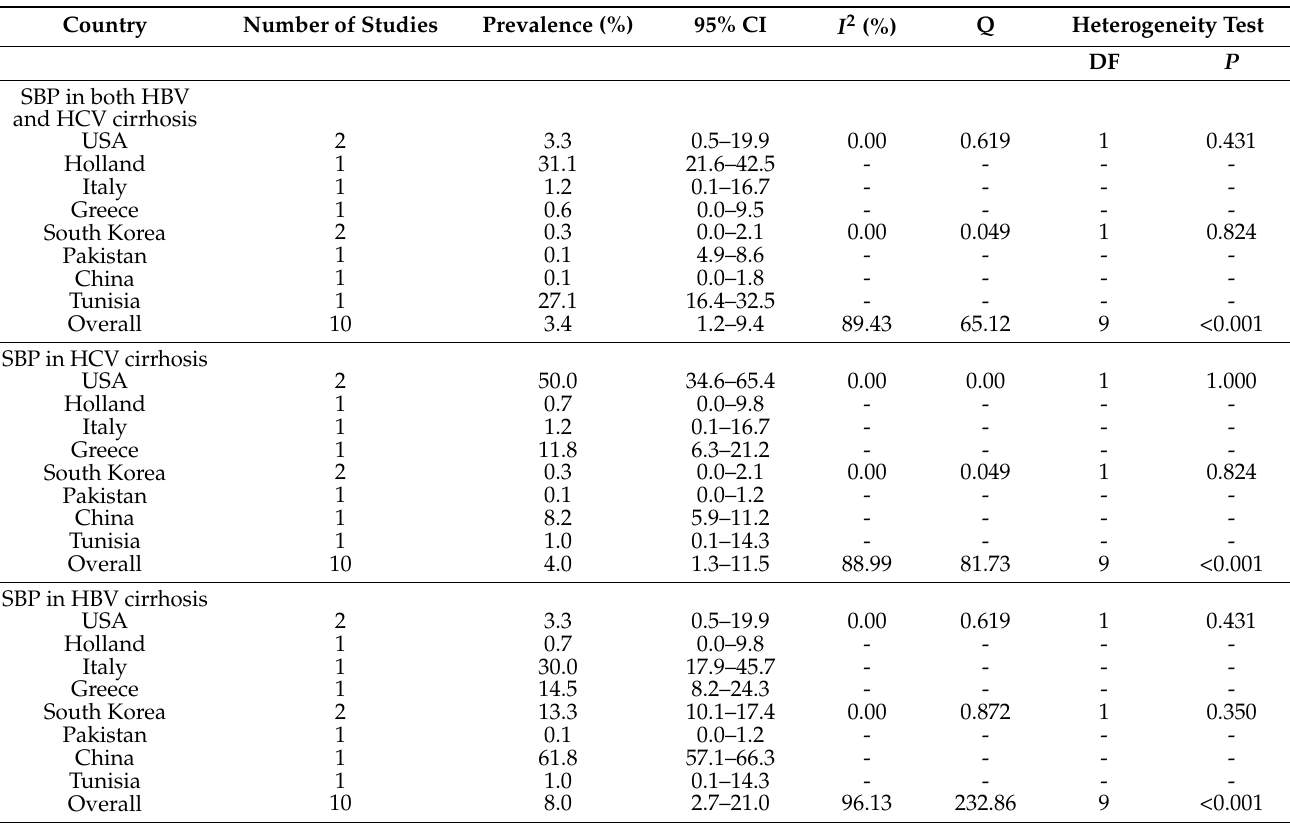
Table 3. Subgroup analysis of SBP in three different viral hepatitis-related liver cirrhosis across